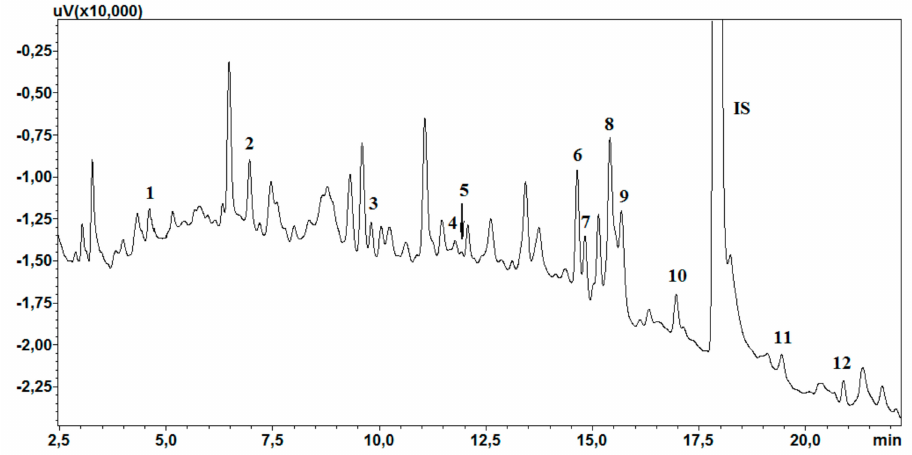
Chromatogram of saliva sample extracts spiked with 10 ng / mL.